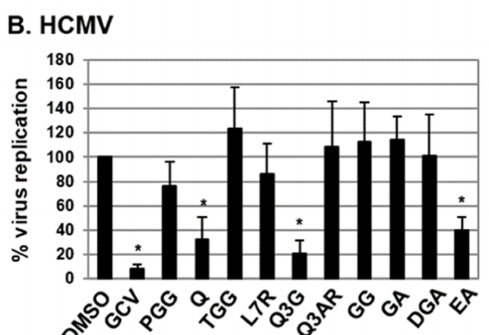
Figure 1. Antiviral activities of chemical components of ethyl acetate (EtOAc) fraction of Elaeocarpus sylvestris (ESE). HFF cells were ( A ) inoculated with varicella-zoster-virus (VZV)–recombinant laboratory pOka strain (pOka)-infected HFF cells or ( B ) infected with human cytomegalovirus (HCMV)–Towne strain (Towne) at an multiplicity of infection (MOI) of 0.1 and treated with DMSO, 1,2,3,4,6-penta-O-galloyl-ß-D-glucose (PGG), quercetin (Q), trigalloyl glucose (1,3,6-tri- O -galloyl- β -D-glucose, TGG), luteolin-7-rutinoside (L7R), isoquercitrin (quercetin 3- O - β -D-glucoside, Q3G), quercetin-3-O-arabinoside (Q3AR), galloyl-D-glucose (1- O -galloyl- β -D-glucose, GG), gallic acid (GA), digallic acid (DGA), and ellagic acid (EA) at a concentration of 20 µ g / mL. As a control, VZV- and HCMV-infected HFF cells were treated with acyclovir (ACV, 1.2 µ g / mL) and ganciclovir (GCV, 2.3 µ g / mL), respectively. At 72 h after infection, total DNA was harvested, and relative amounts of viral DNA determined via qPCR using primers specific for VZV ORF62 or HCMV UL123. For quantitative assessment of the relative abundance of viral DNA between samples, the value of virus-infected cells treated with DMSO was set at 100. Significant differences between samples were determined using Student’s t test (significant at * p < 0.05). Data shown here represent three independent sets of experiments. Molecules 2019 , 24 , x FOR PEER REVIEW